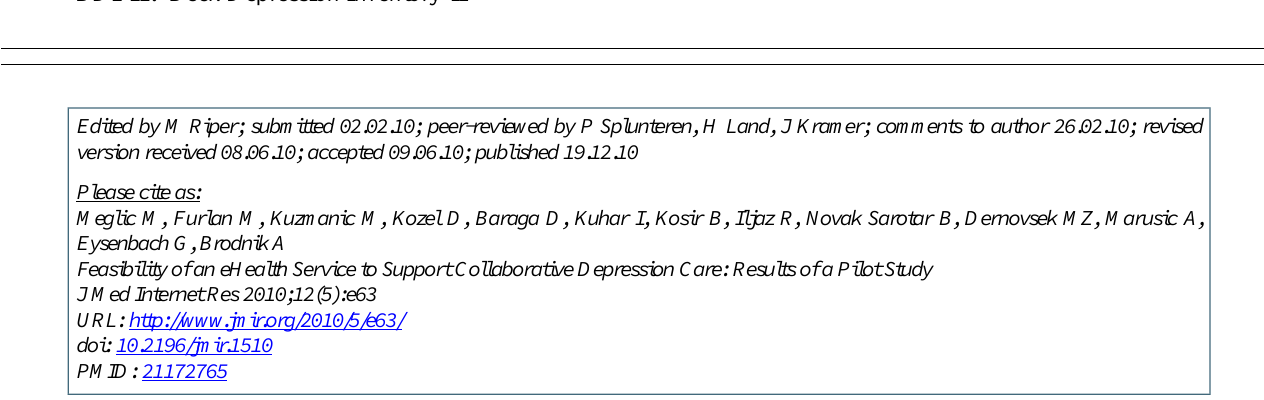
BDI-II: Beck Depression